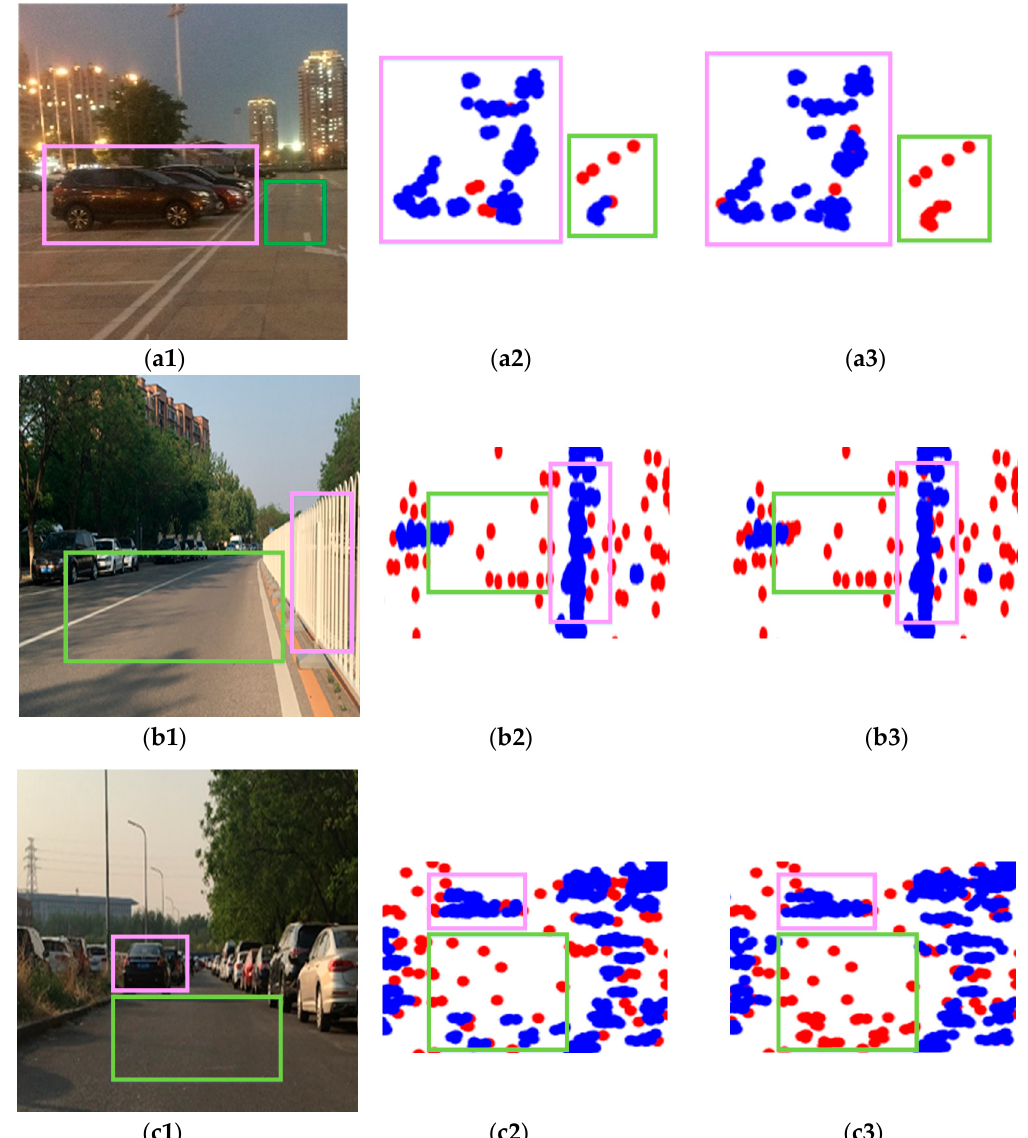
Figure 12. The three sets of pictures. ( a – c ) correspond to three scenes. ( a1 – c1 ) Partial image of the real scene; ( a2 – c2 ) Outlier recognition result when RCS feature is not used, red is outlier; ( a3 – c3 ) Outlier recognition result when RCS feature is used, red is outlier.